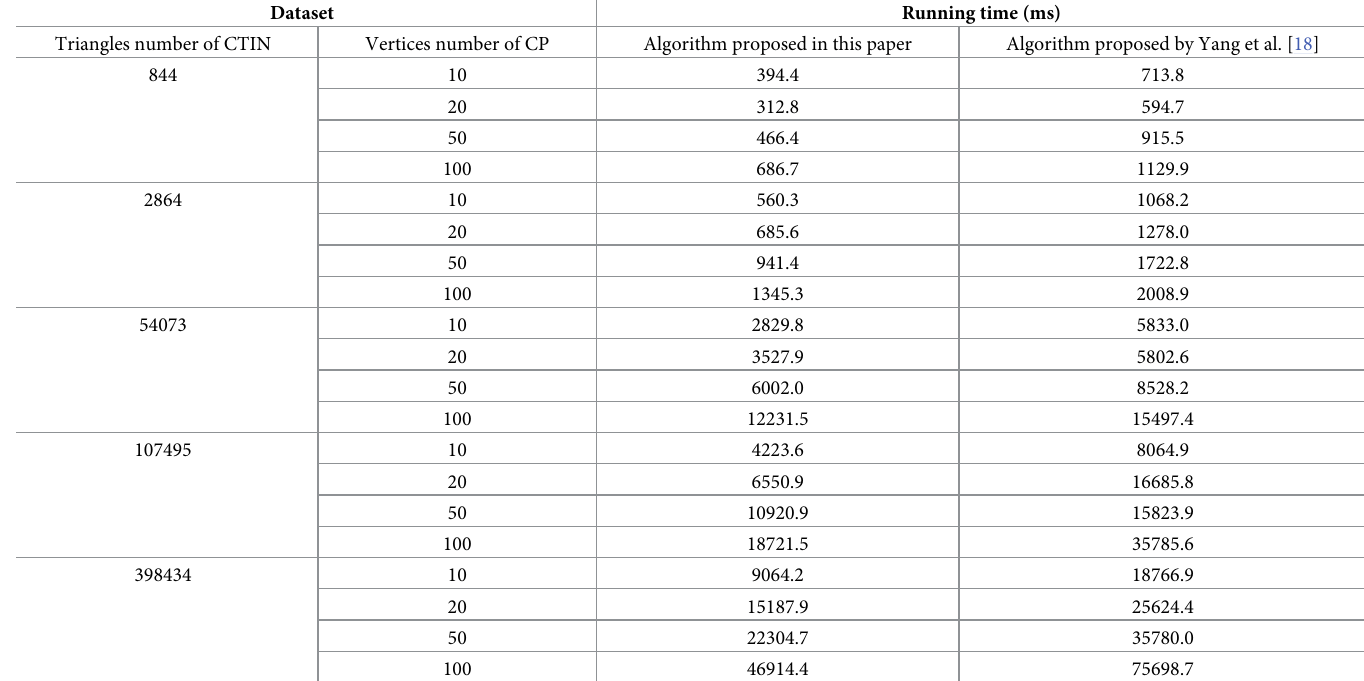
Table 1. Time efficiency